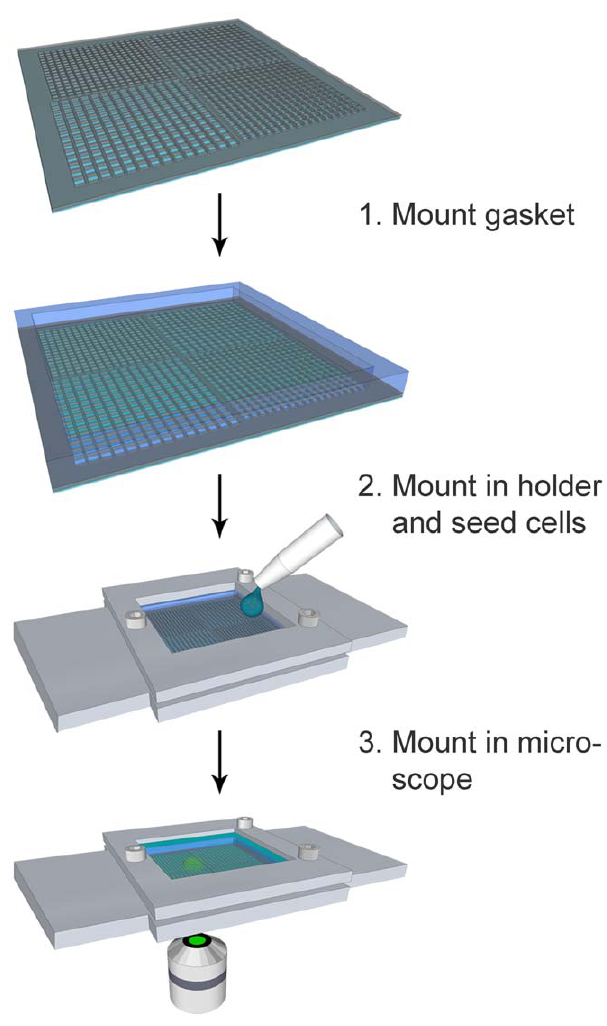
Figure 3. Preparation of silicon chips for microscopy. The silicon chips were primed by degassing the chip submerged in cell medium until the wells were filled with medium. A PDMS-gasket was mounted onto the perimeter of the silicon chip (1). The chip was then mounted in the custom made holder, where tight clamping of the gasket to the chip prevented leakage. Cell suspension was dropped onto the wet chip, and after seeding the chip was washed multiple times (2). Finally, additional medium was added and the chip imaged (3).